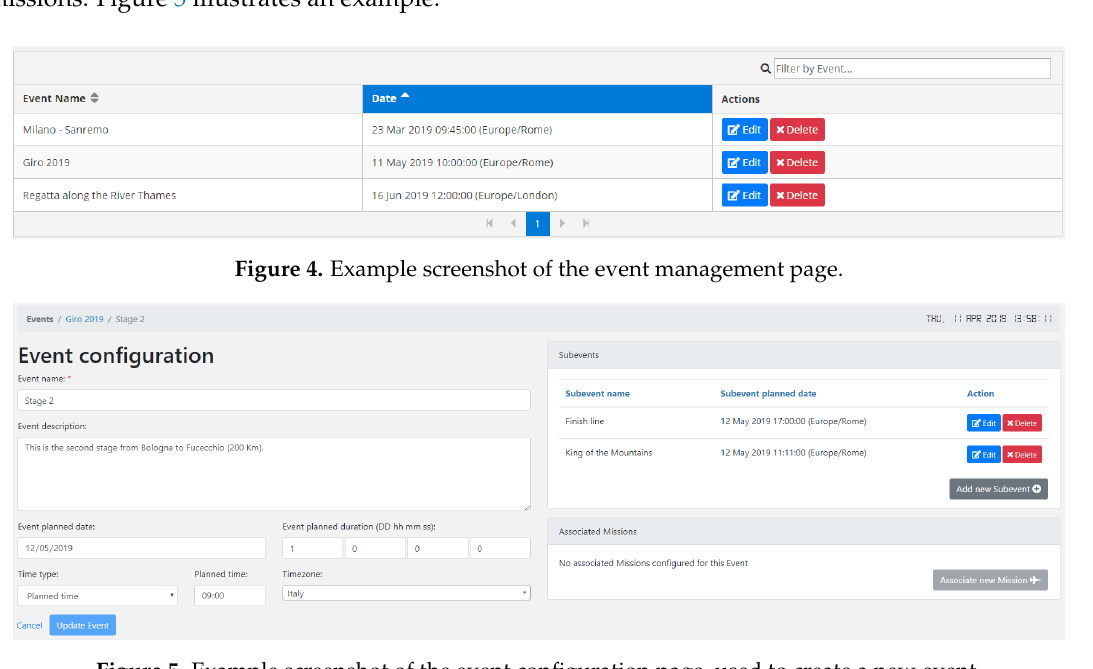
Figure 5. Example screenshot of the event configuration page, used to create a new